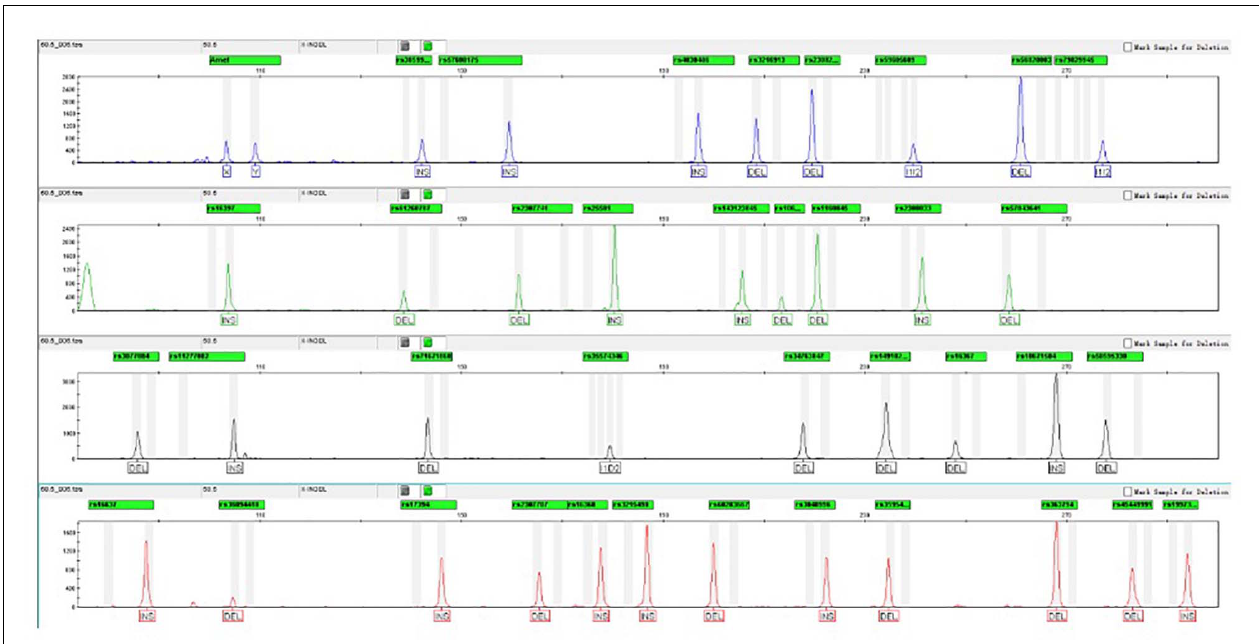
FIGURE 4 | Electropherograms of control DNA 9948 amplified using the AGCU X-InDel 38 kit at 58.5 ◦ C.